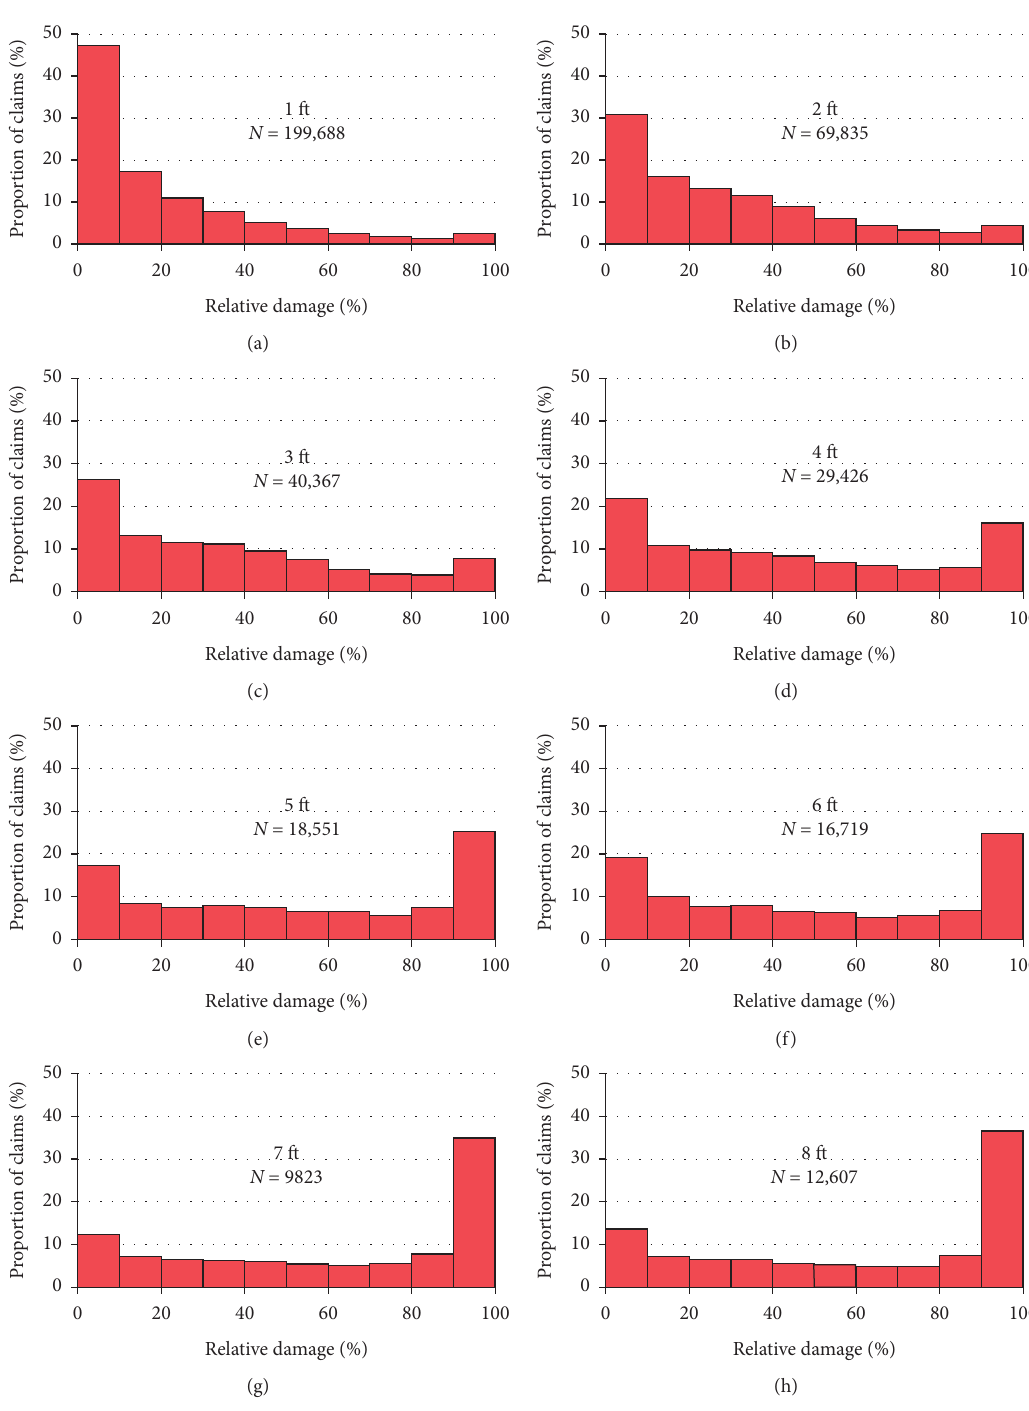
Figure 3: The distributions of different consumer groups of luxury